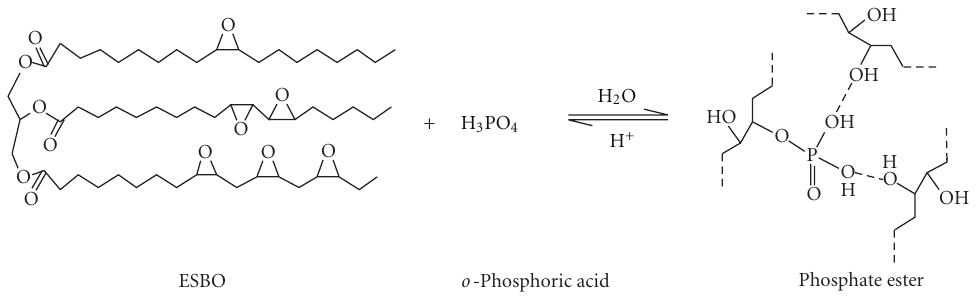
Figure 1: Schematic representation of soy-phosphate